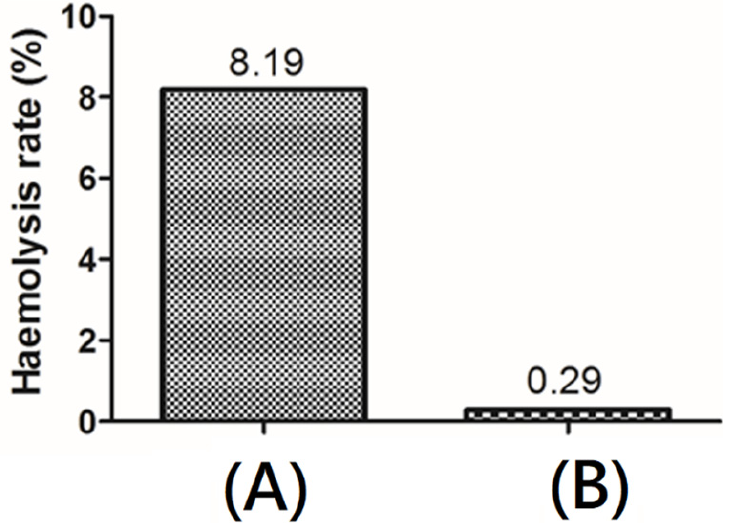
Figure 7. Hemocompatibility of ( A ) original porcine dermal and ( B ) decellularized bio-scaffold.